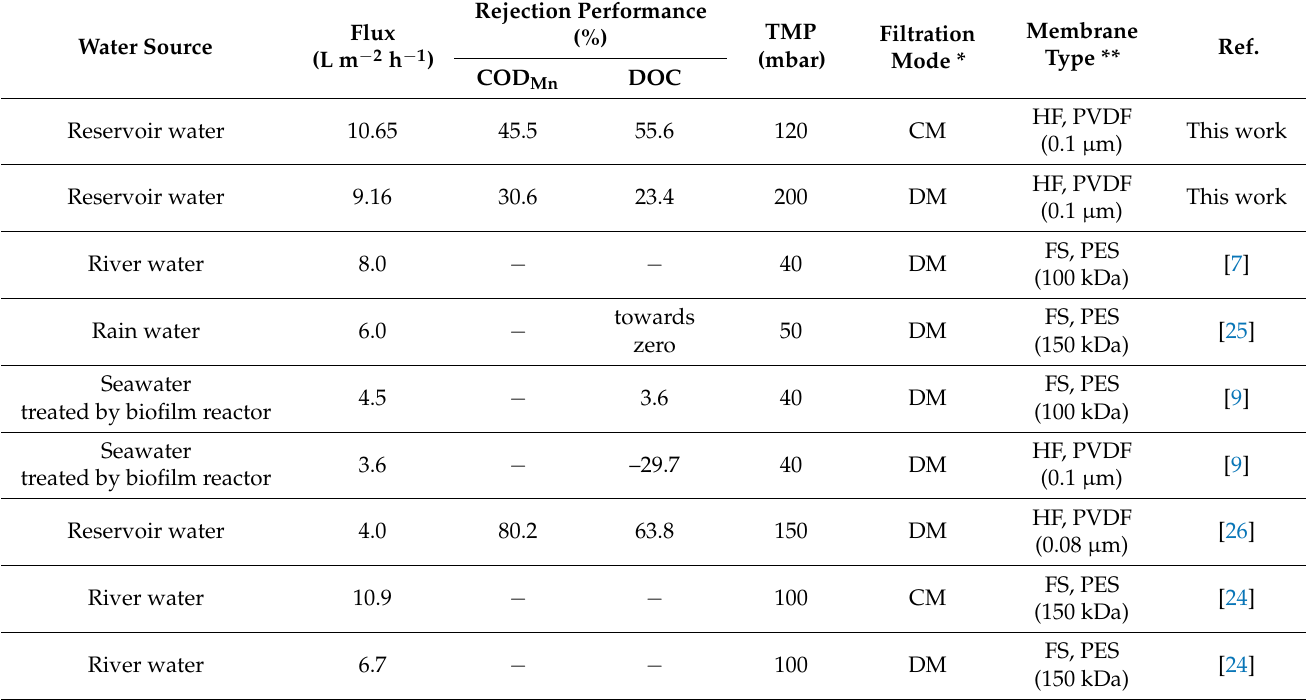
Table 4. Comparison for applications of GDM